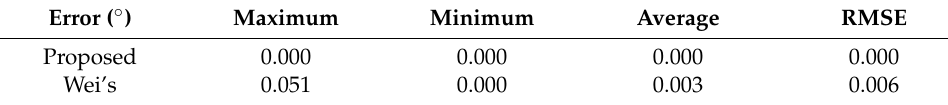
Table 3. The error of the slope.